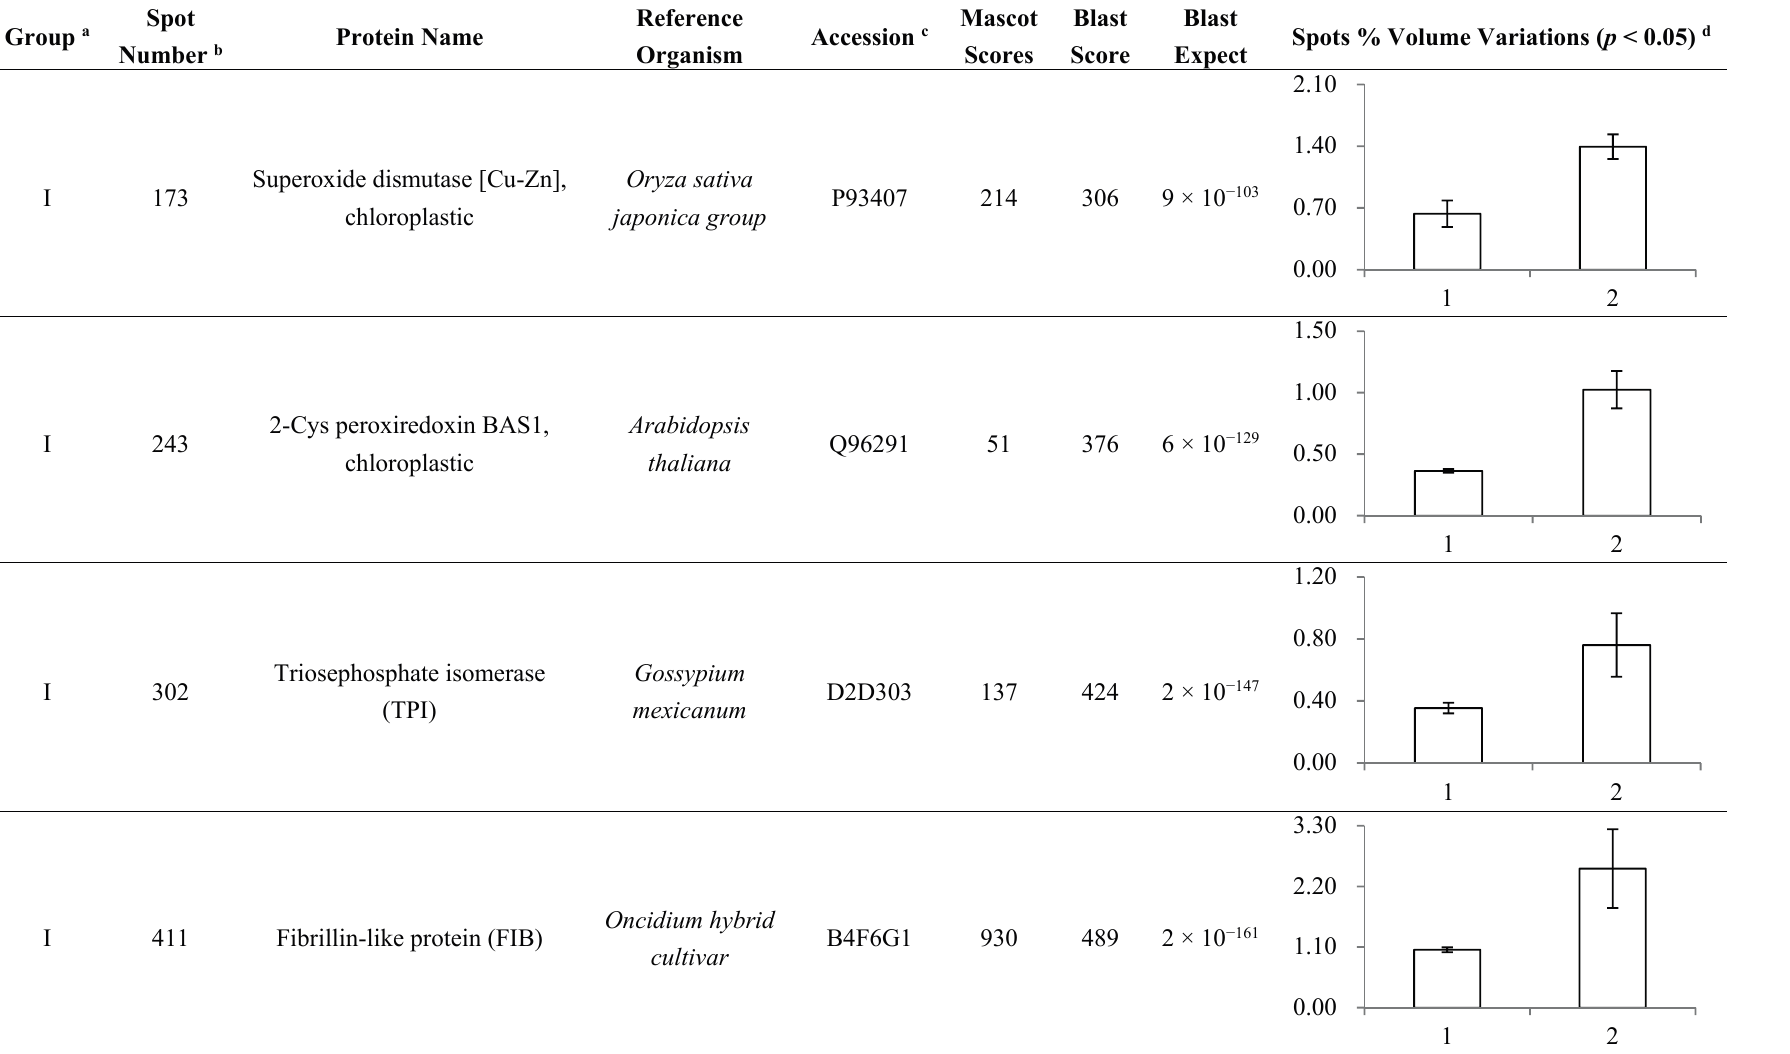
Table 1. Identification of 21 proteins that differentially expressed in labellum and inner lateral